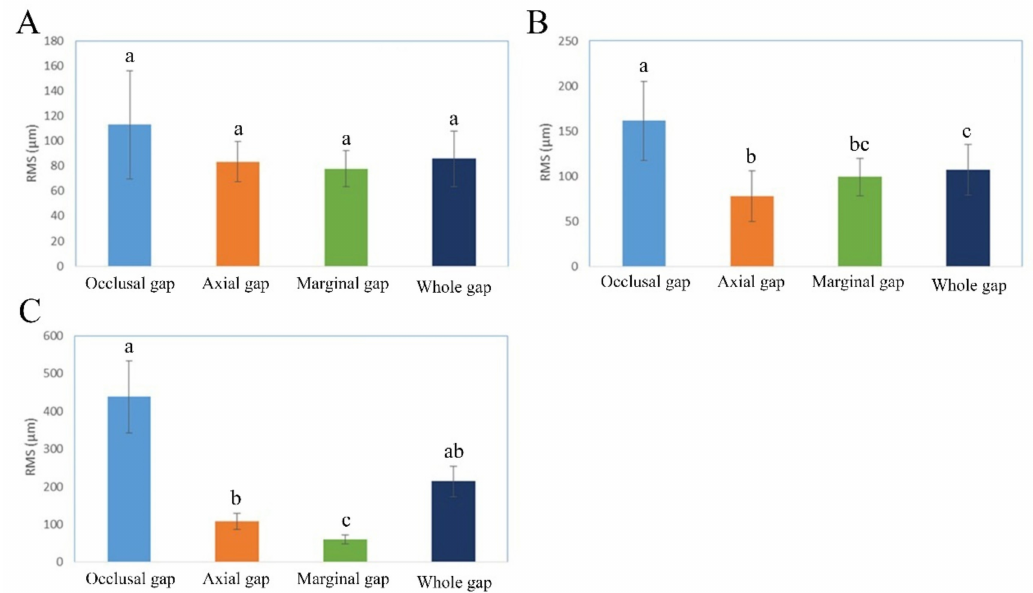
Figure 7. Marginal and internal fit comparison within each group. ( A ) CEREC system; ( B ) EZIS system; ( C ) Carestream system. Values with the same letter (a, b, c) are not statistically different based on a pairwise comparison test ( p <